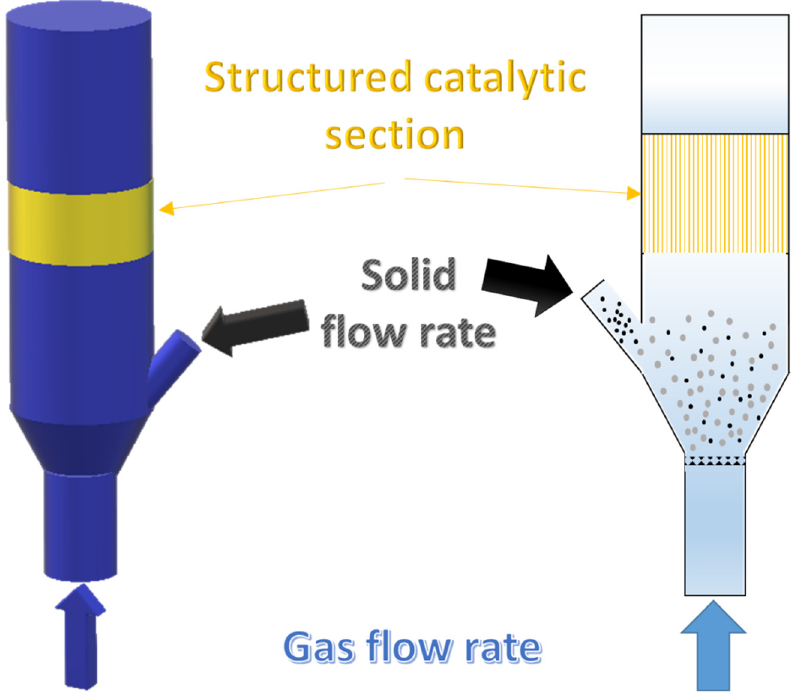
Figure 6. Sketch of the “hybrid” fluidized bed gasifier enhanced by a structured catalyst placed in the freeboard.